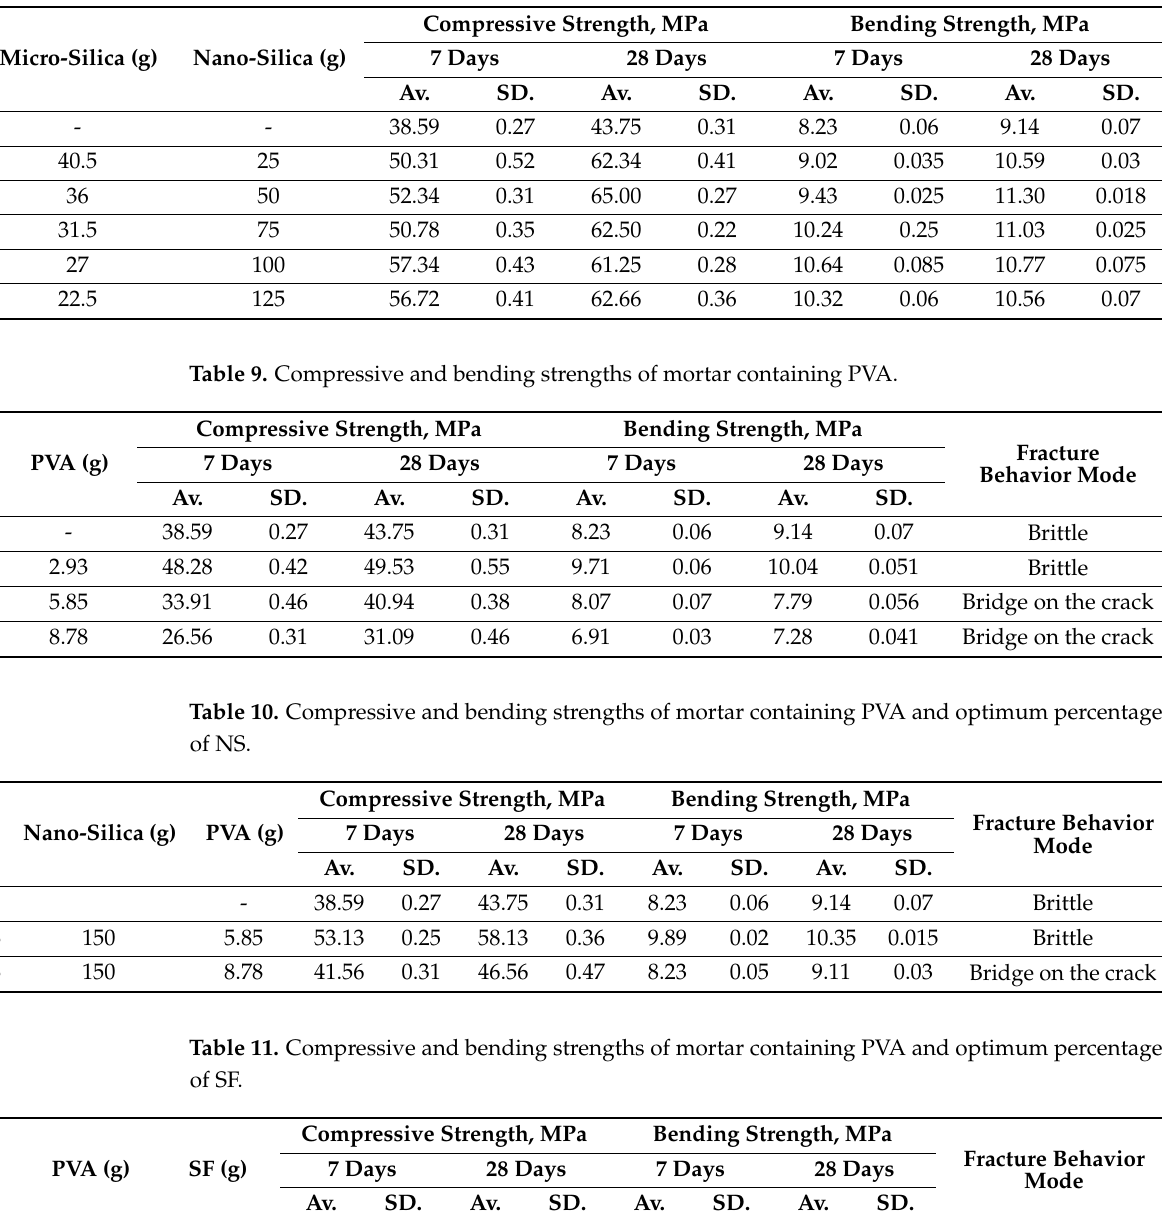
Table 8. Compressive and bending strength of mortar containing micro-silica and nano-silica.